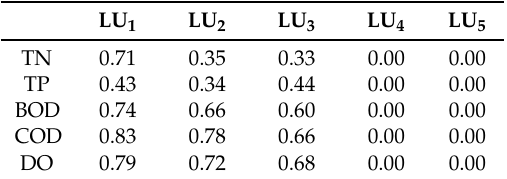
Table 5. Accuracy of the predictions at the scale of individual land cover types.